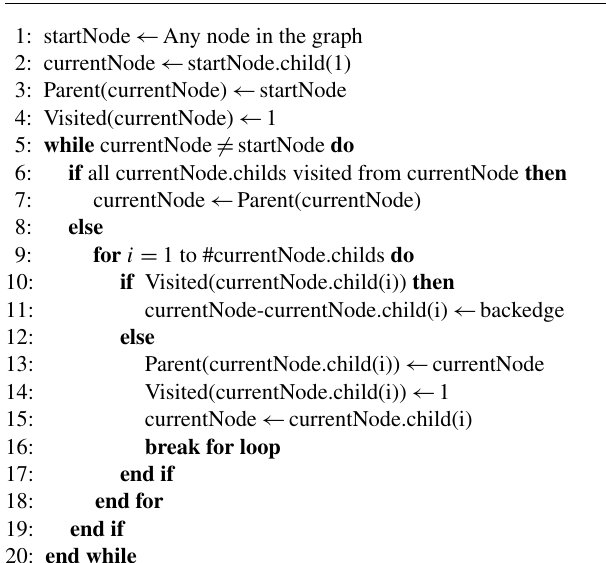
Algorithm 2 Depth first search for finding the back edges of a graph.